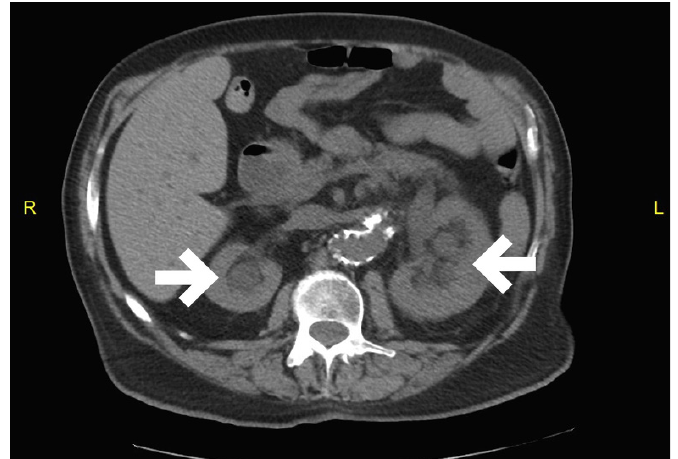
Image 2 . Computed tomography of the abdomen and pelvis in